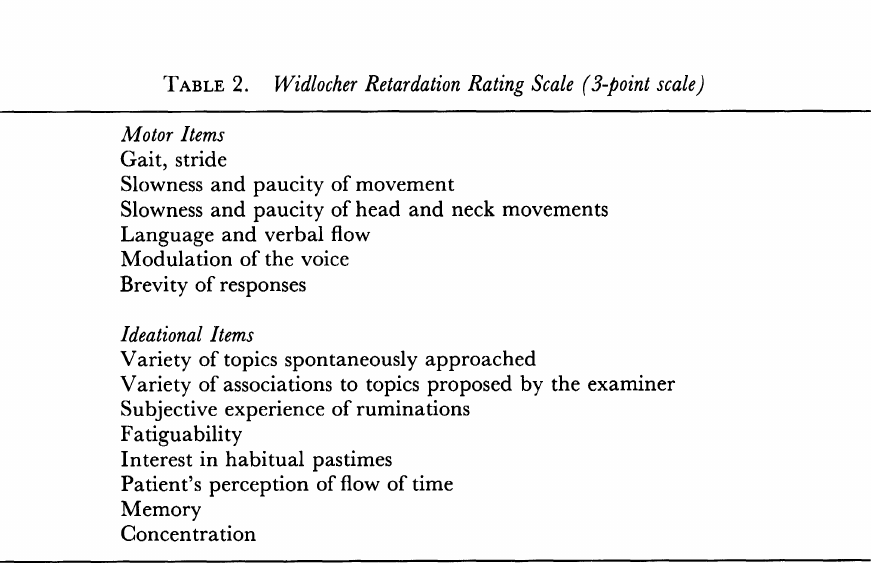
Widlocher Retardation Rating Scale (3-point